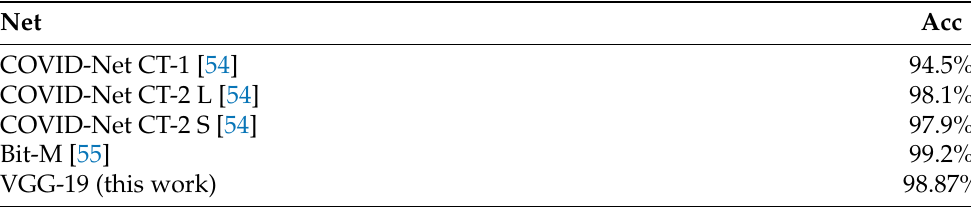
Table 6. Comparison of our work with the state of the art on COVIDx